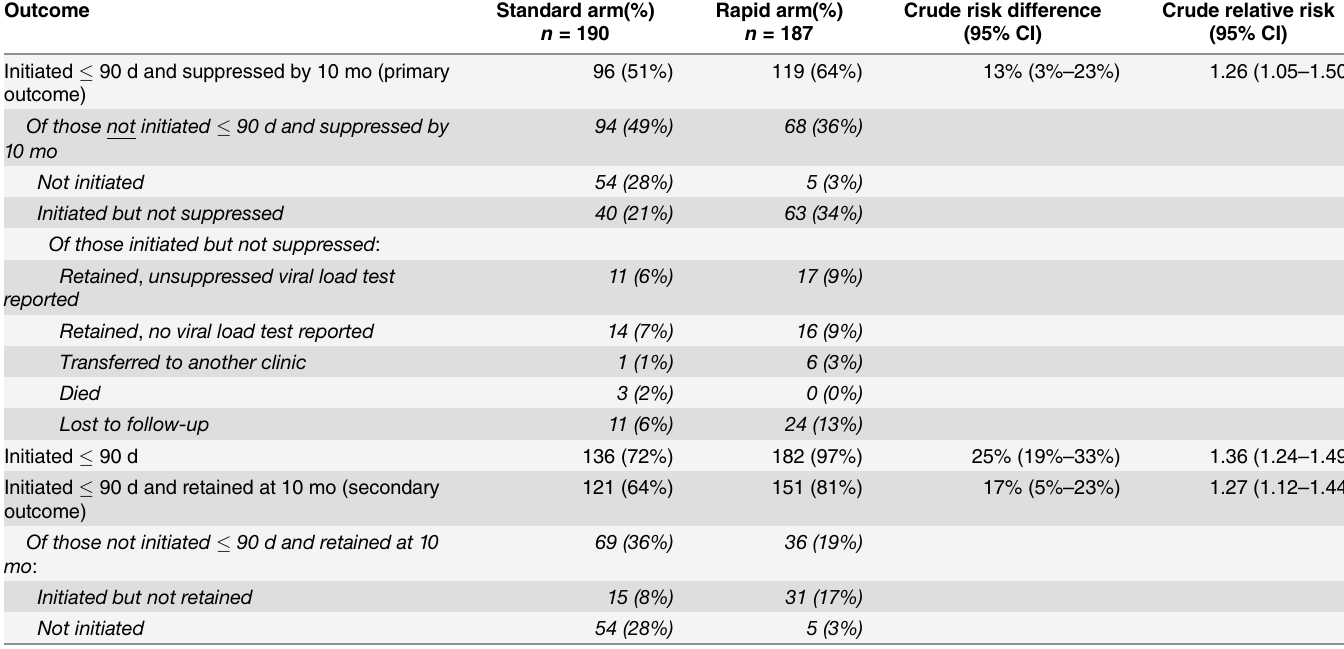
Table 2. ART initiation, 10-mo retention in care, and 10-mo viral